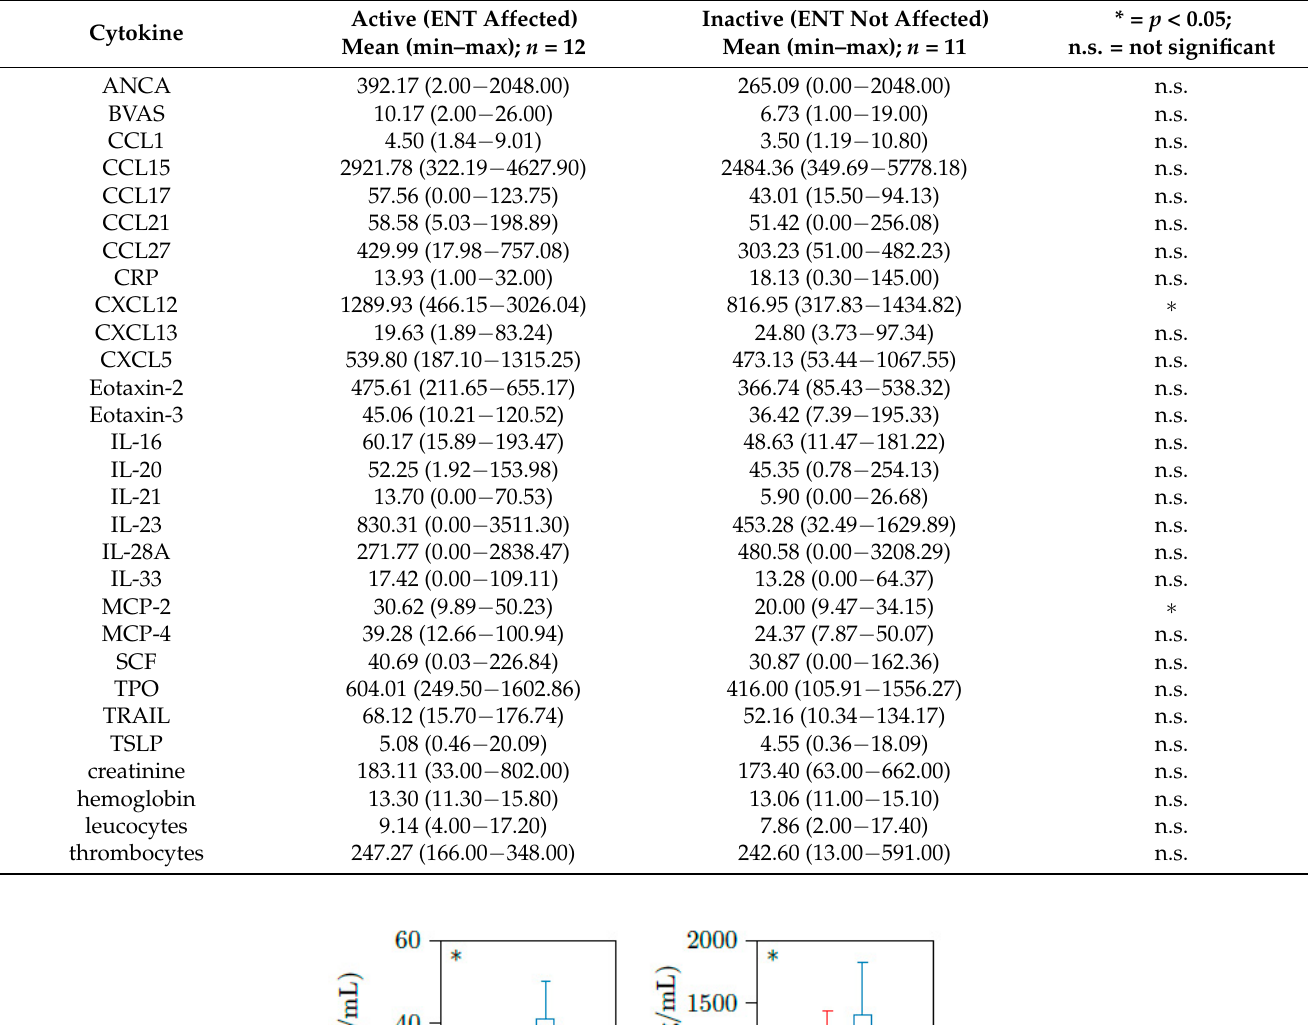
Table 3. Cytokines, laboratory parameter, PR3-ANCA titer and BVAS at active AAV differentiated in presence of ear, nose, and throat (ENT) involvement and no ENT involvement.